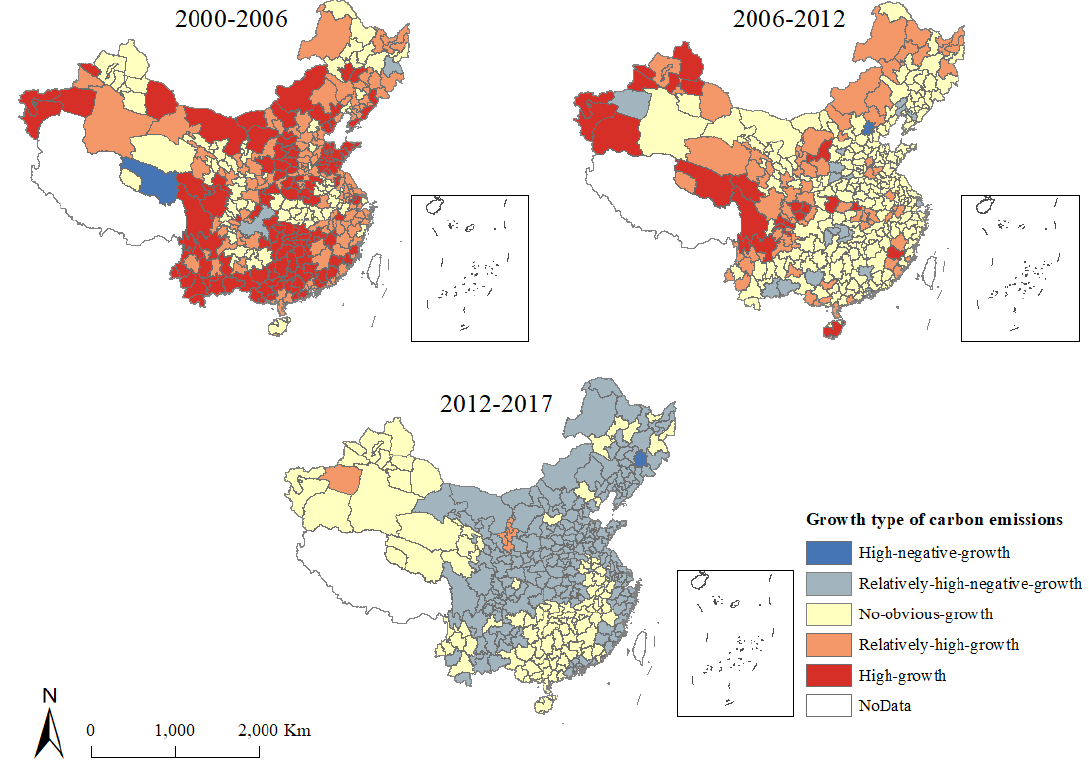
Figure 5. Growth types of carbon emissions at the city level for the periods 2000–2017.